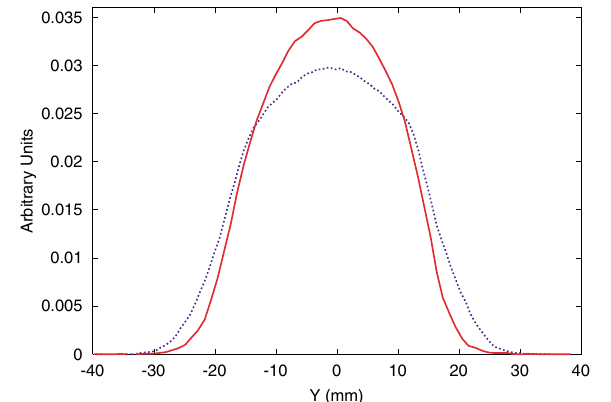
FIG. 13. (Color) Incoherent particle tunes taken from PIC simulation versus longitudinal coordinate for the high intensity beam. The blue points represent the beam without the longitu- dinal notch, and the red points represent the beam with the longitudinal notch.